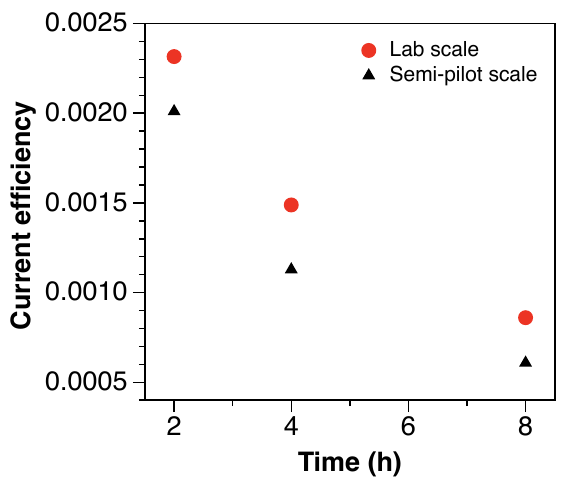
Figure 5. Coulombic efficiency (CE) for fluoride generation during the electrochemical treatment of a synthetic still bottoms solution at the laboratory and semi-pilot scales. The applied current density was 50 mA/cm 2